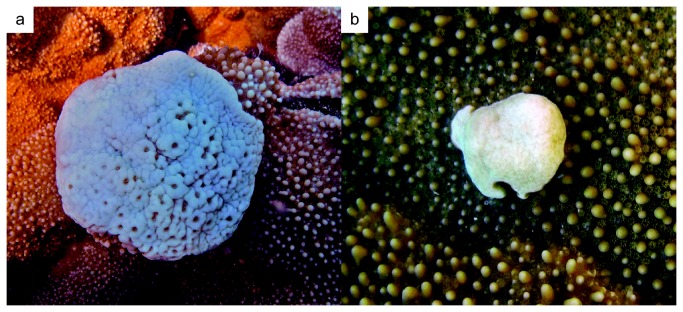
Type A and Type B GA morphology.Photographs of Type A and Type B GA tissue. a Type A GA, note reduction in polyps, fused tuberculae, and pale appearance b Type B GA, note complete lack of polyps, fused protuberant coenosteum, and pale appearance.